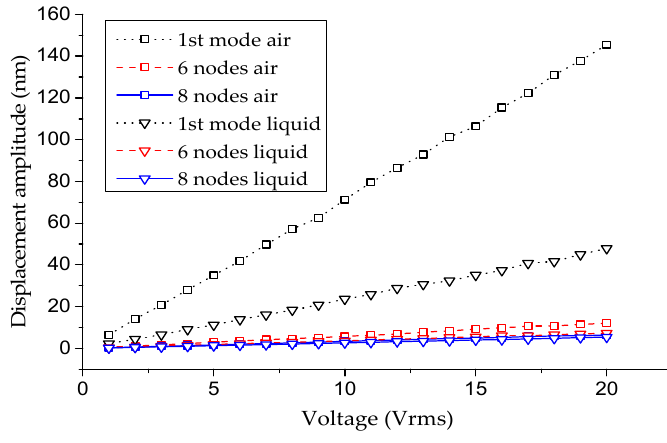
Figure 4. Maximum displacement amplitudes for different modes in function of applied voltage.